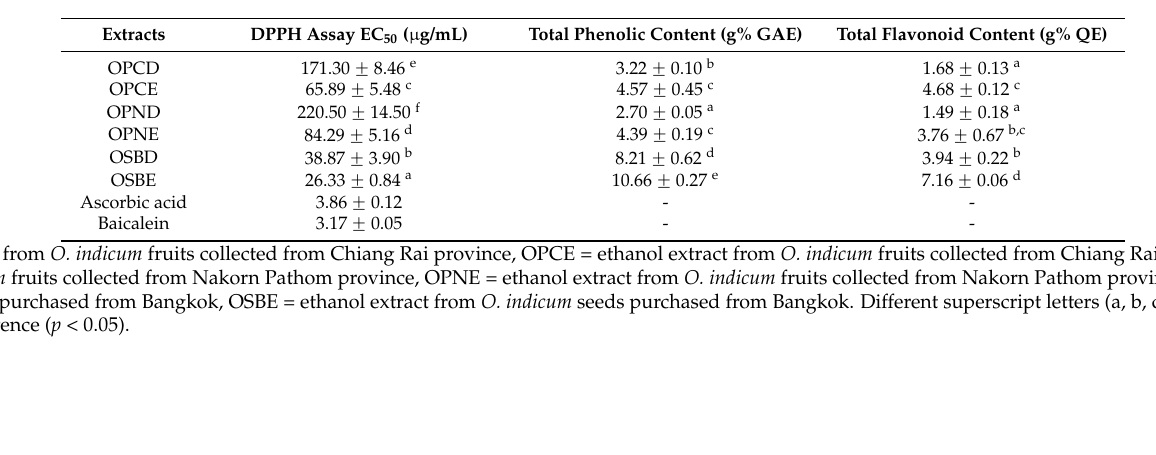
Table 2. Antioxidant activity, total phenolic and total flavonoid contents of O. indicum